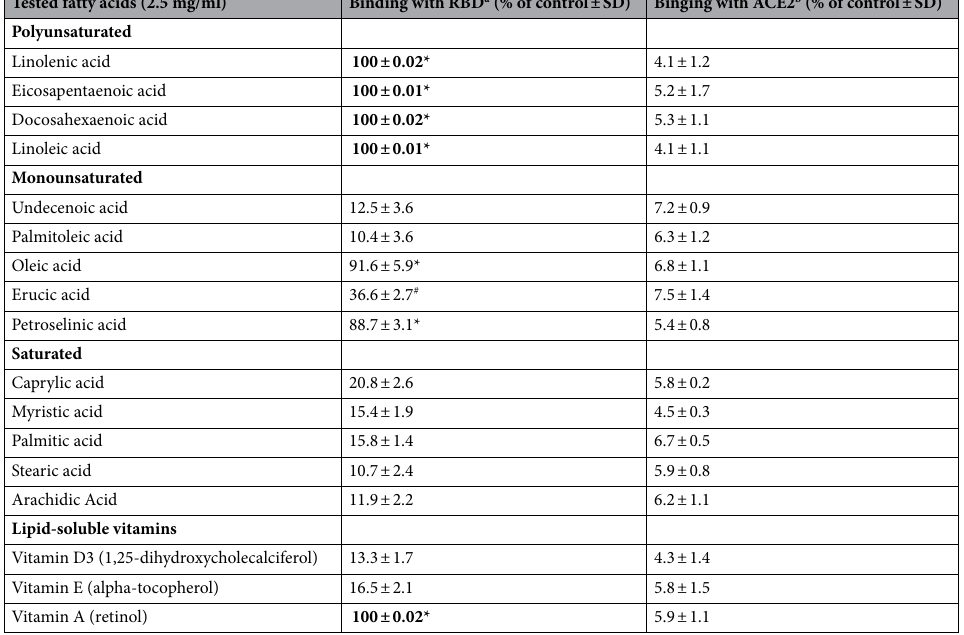
Table 1. Effect of FAs and lipid-soluble vitamins on binding with SARS-CoV-2 spike RBD and hACE2 receptor. Bold indicates the highest binding efficacy. a 2.5 mg/ml of tested lipids and lipid-soluble vitamins were first incubated with HRP-conjugated RBD for 30 min at 37 °C and then transferred into a 96-well plate with immobilized hACE2 receptor and incubated for an additional 15 min at 37 °C. Plates were then washed four times and developed with TMB substrate solution for up to 5 min, followed by the addition of stop buffer. Optical density was immediately measured at 450 nm. b 2.5 mg/ml of tested lipids and lipid-soluble vitamins were first incubated with hACE2 immobilized on a 96-well plate for 30 min at 37 °C and then hACE2- immobilized plates were washed four times, and incubated with HRP-conjugated RBD for 15 min at 37 °C. Plates were then washed four times and developed with TMB substrate solution for up to 5 min, followed by the addition of stop buffer. Optical density was immediately measured at 450 nm. # p ≤ 0.05, * p ≤ 0.001.